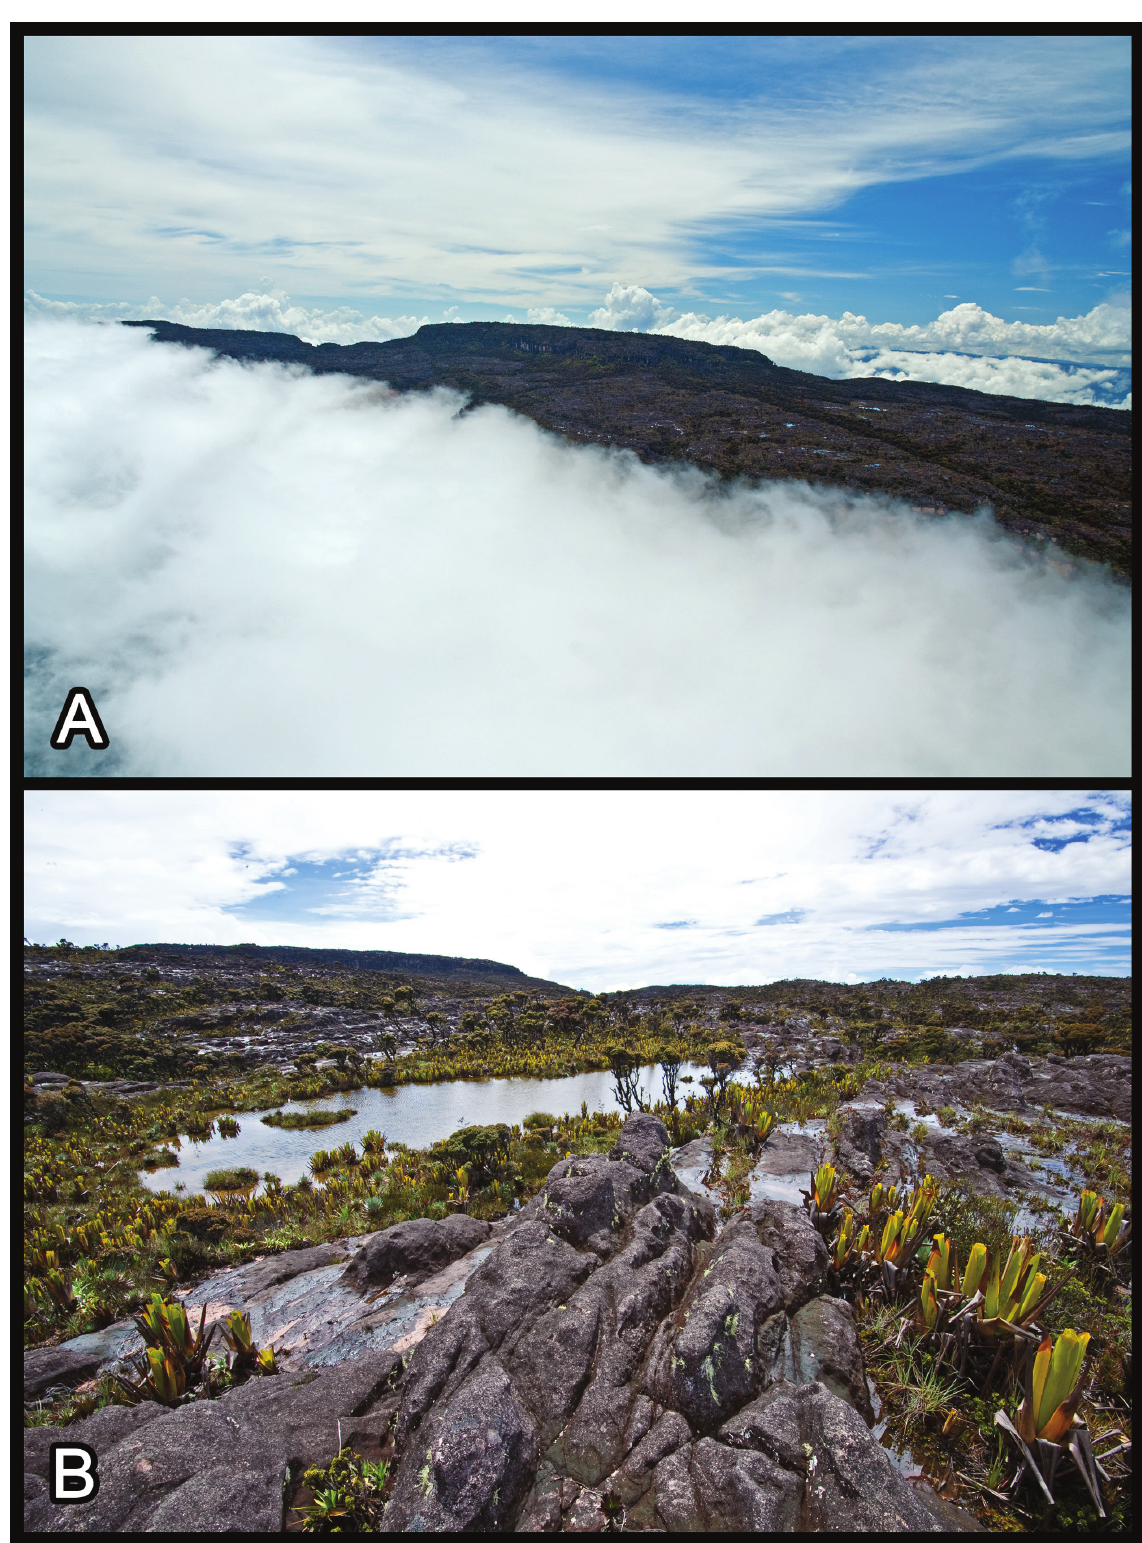
Fig. 7. A . The summit of Aprada-tepui lying above the clouds, photographed from a helicopter looking to the SW (2 May 2011). B . Summit of Aprada-tepui (15 Jun. 2012). Photographs by the